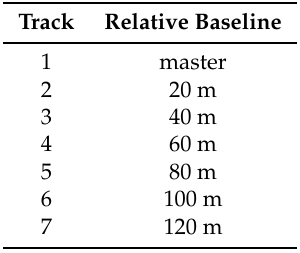
Table 3. Baseline configuration of multibaseline UAVSAR